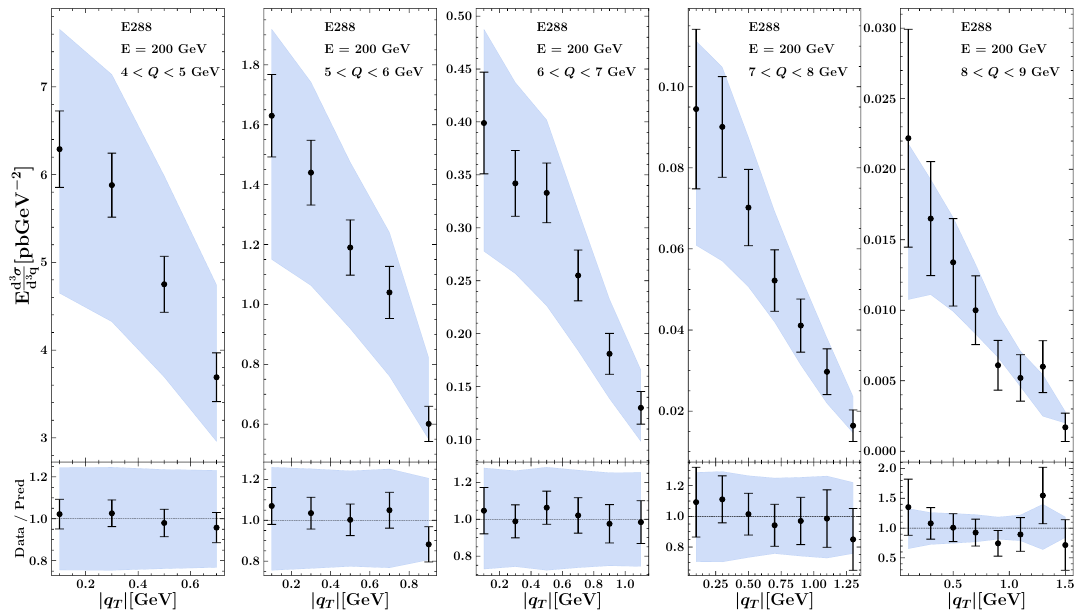
Figure 8 . Upper panel: comparison between data and theoretical predictions for the DY cross section differential in for the E288 dataset at E = 200 GeV for different Q bins; uncertainty q T beam | | bands correspond to the 68% CL. Lower panel: ratio between experimental data and theoretical cross